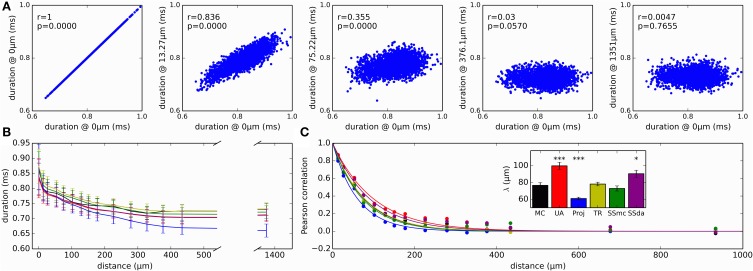
Variability and correlations in the duration of action potentials. (A) Duration of all action potentials (measured at 0 mV) at different positions of the axon, plotted against the duration at a site near the initiation site. This reference location is designated as “0 μm.” Data presented correspond to simulation with MC. r is the Pearson correlation coefficient and p is the associated p-value when testing for a correlation different to 0. (B) Evolution of action potential duration along the axon, for the different simulation algorithms. Data is mean ± SD. (C) Correlation of action potential duration at different points in the axon, with the duration at the reference “0 μm” location. Lines represent the fit to a single exponential decay. Inset: length constants λ obtained in the fit of the different data sets. Error bars represent the SD of the parameter estimation. The fits were compared to MC using an extra sum of squares F test, to test the hypothesis that each data set and the MC set could be fit with the same parameter λ. ***p < 0.001, *p < 0.05.